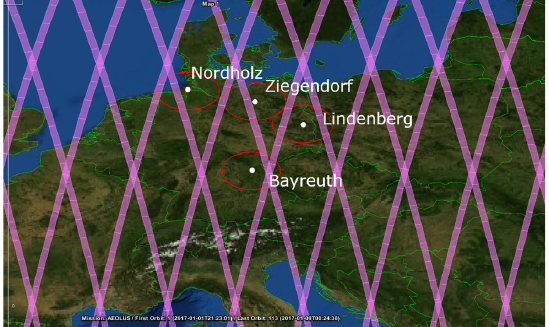
Fig. 1: Map of Central Europe showing the predicted Aeolus ground tracks of one week (magenta) and the four radar wind profiler stations of DWD (white) with a surrounding radius of 100 km (red).